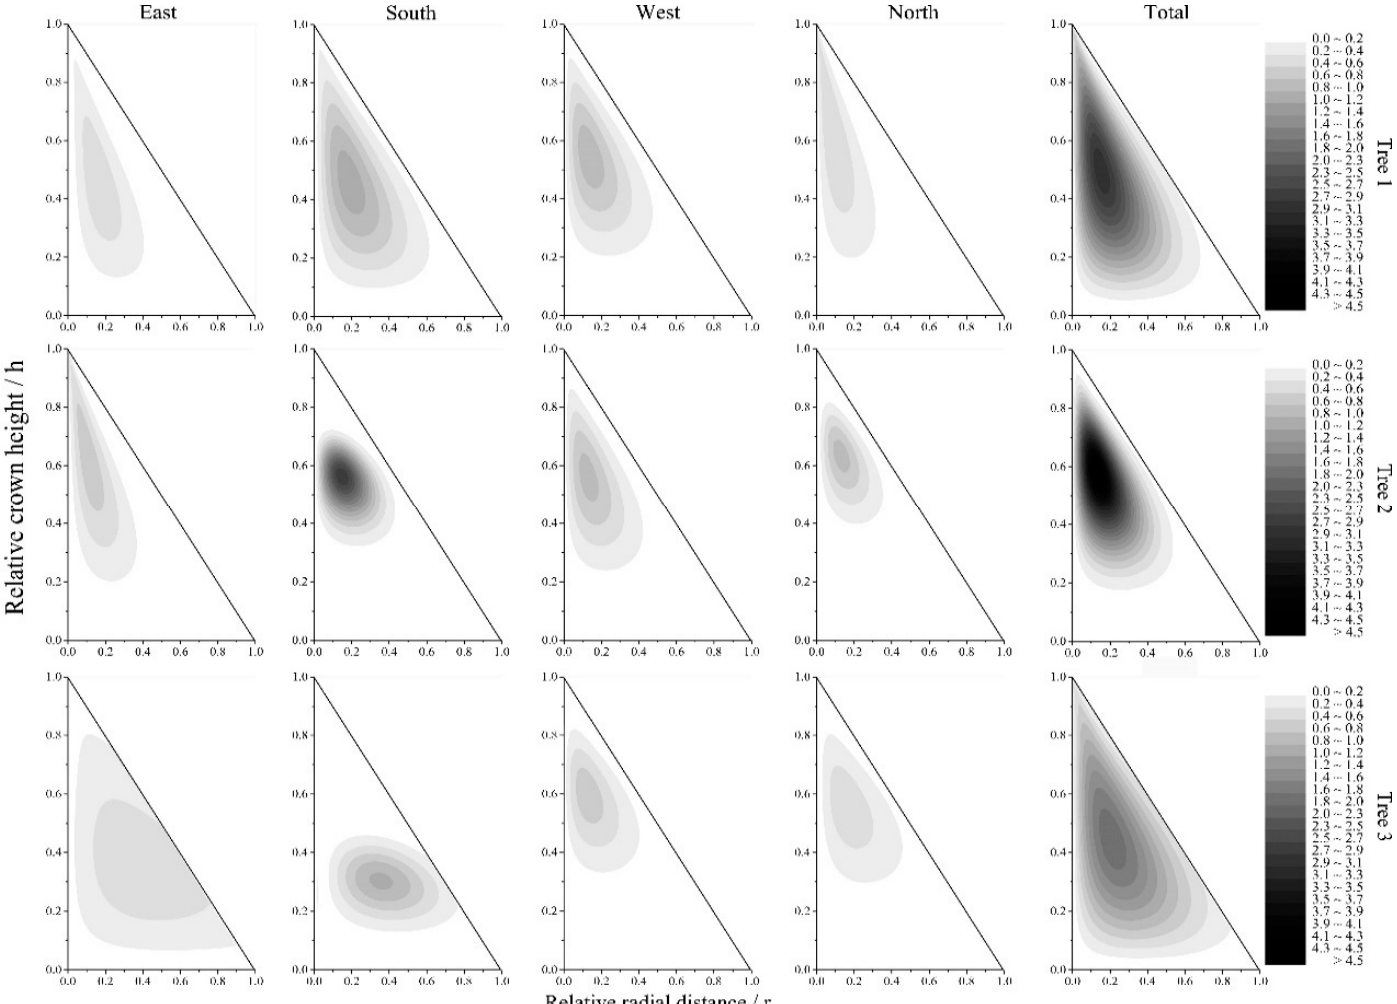
Figure 9. The results of the simulation of a two-dimensional NA for the whole and different directions of crowns for three sample trees.